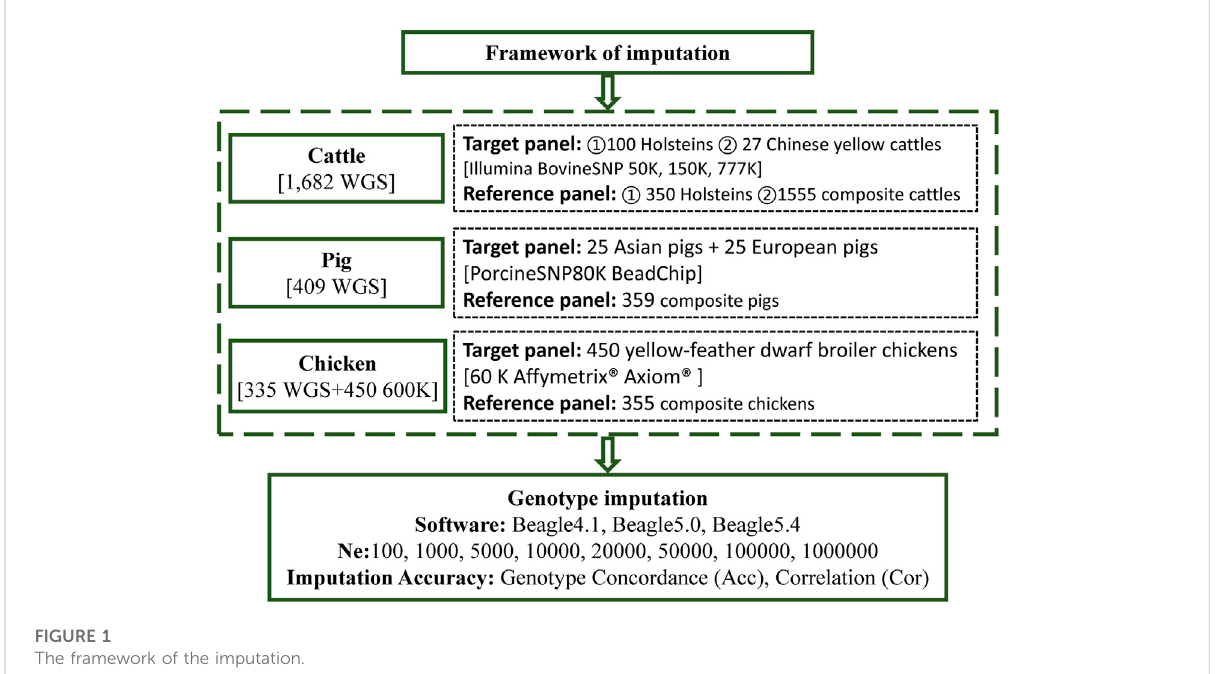
FIGURE 1 The framework of the imputation.